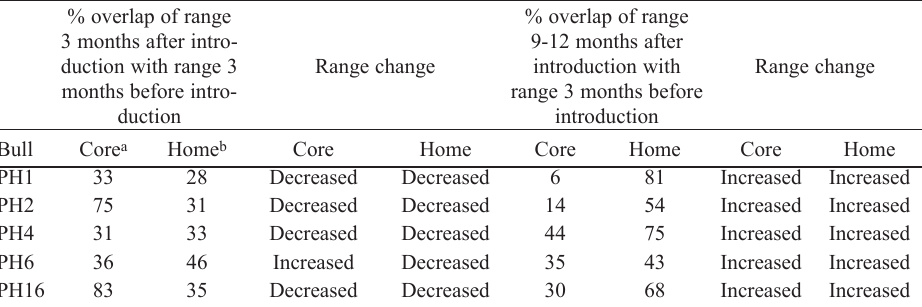
Table 1 Effect of bull introductions on ranging patterns of resident bulls and changes in ranging patterns of introduced